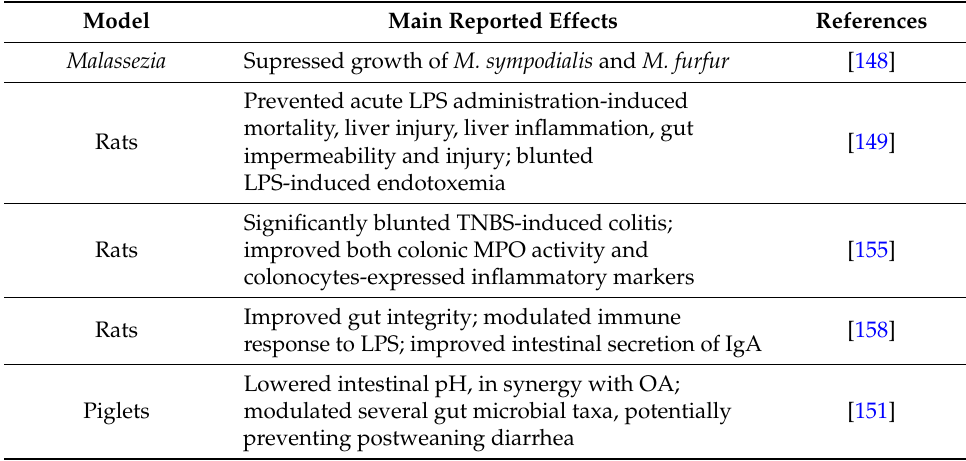
Table 2. Antimicrobial and gut-managing effects of MCT.